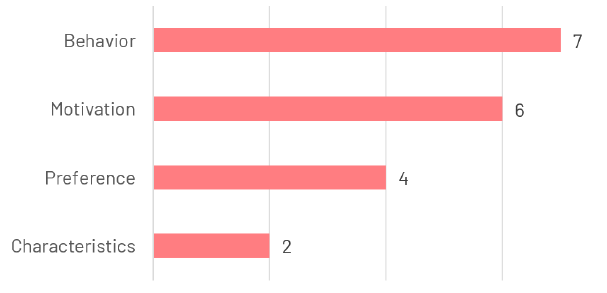
Figure 4. Identified classification entities